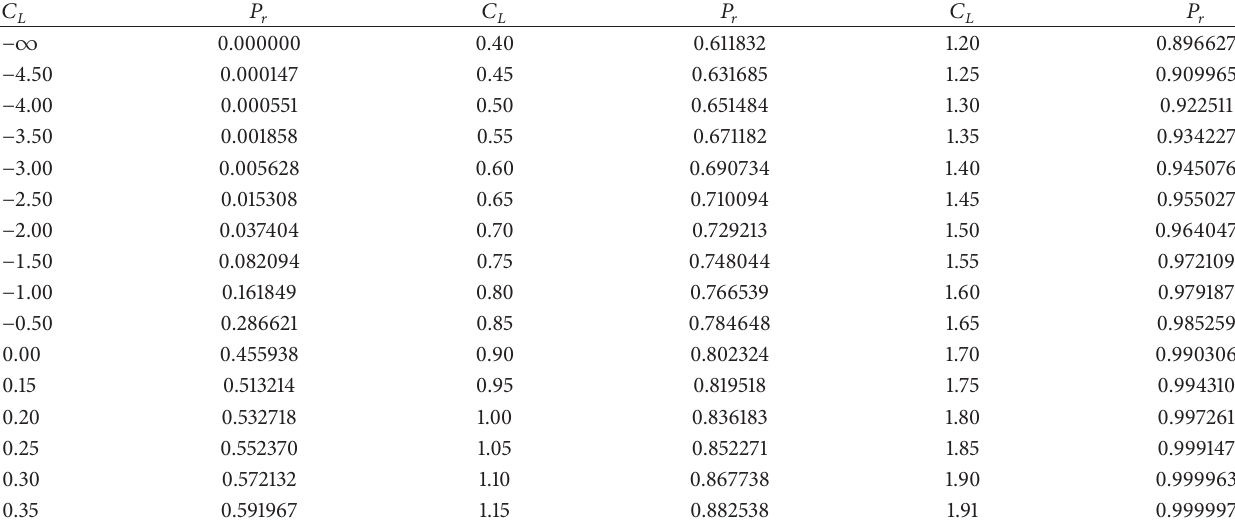
Table 1: The lifetime performance index 𝐶 𝐿 versus the conforming rate 𝑃 𝑟